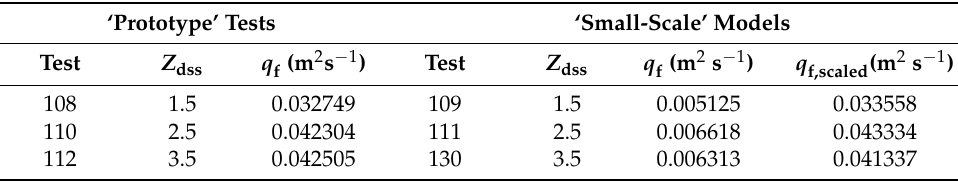
Table 3. Summary of the specific campaign to assess the scale